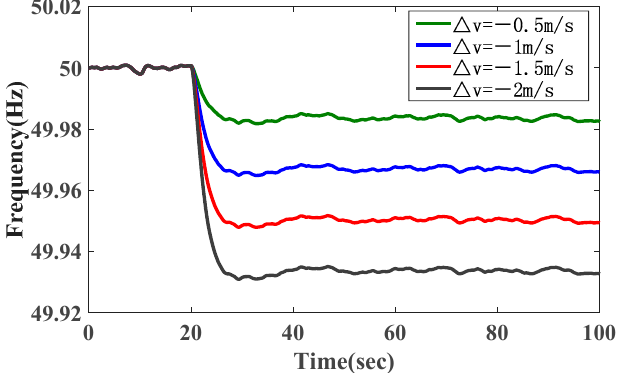
Figure 20. Frequency response for varying values of wind speed v .